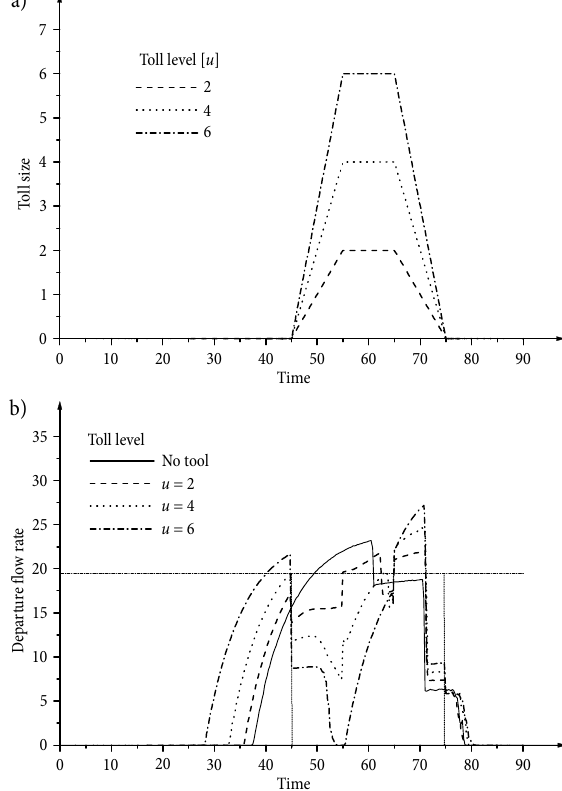
Fig. 10. Solution profiles from the second type of toll